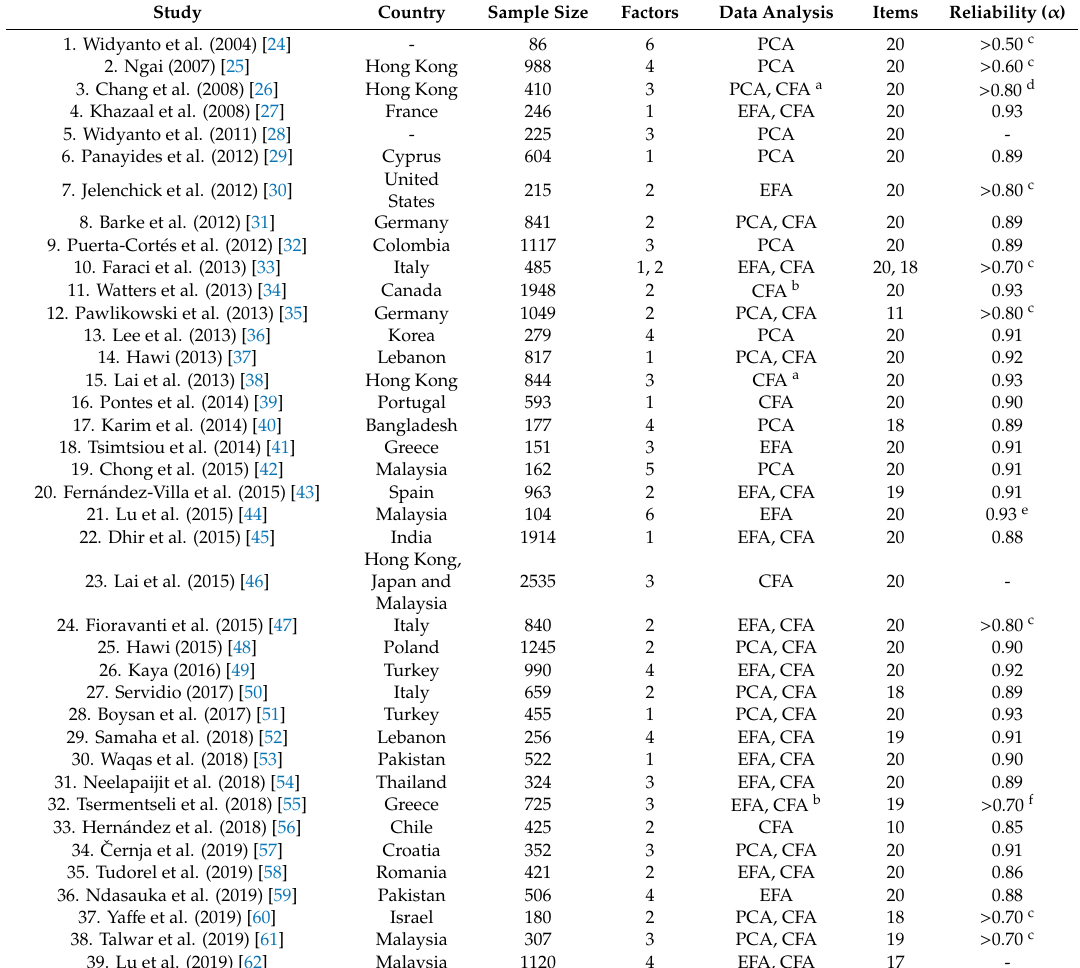
Table 1. Previous studies on psychometric properties of the Internet Addiction Test (IAT). Study Country Sample Size Factors Data Analysis